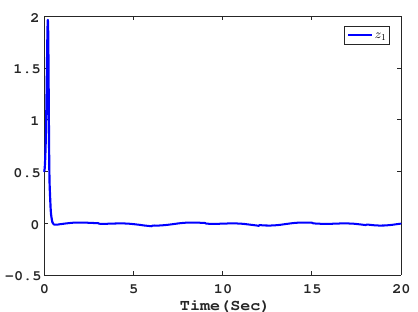
Figure 4. The trajectory of the tracking error z 1